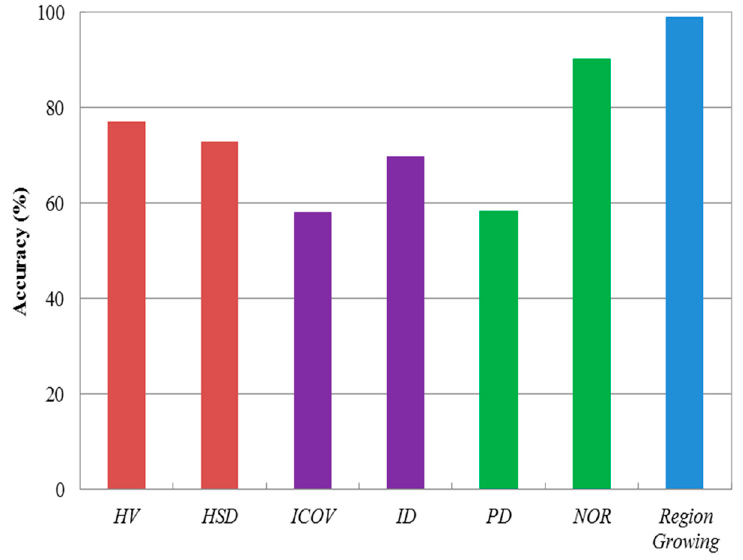
Figure 9. Average overall accuracies based on different point features and seeded region growing.